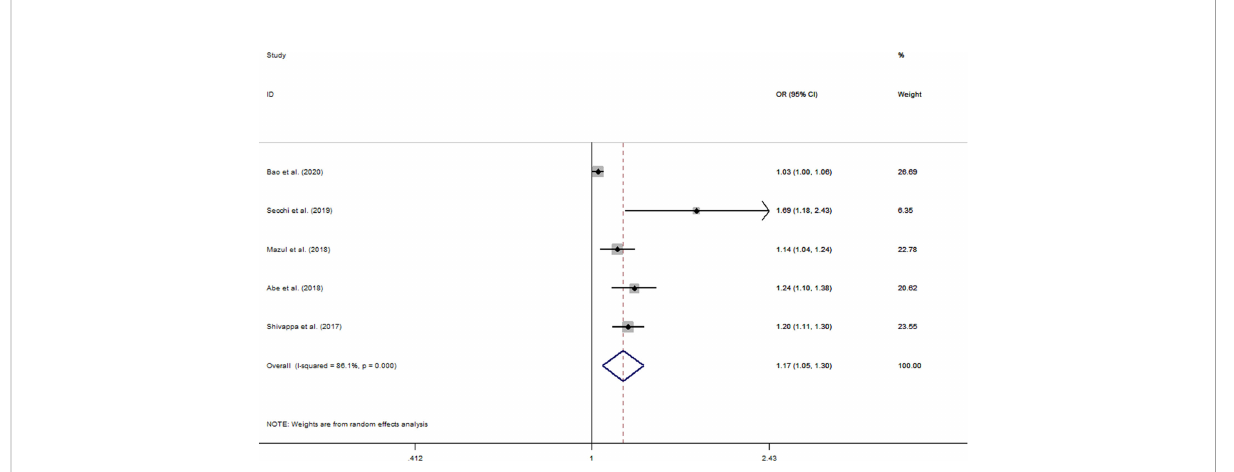
FIGURE 3 Forest plots of pooled odds ratios (ORs) with corresponding 95% con fi dence intervals (CIs) of oral cancer risk for per 1-unit increase in DII